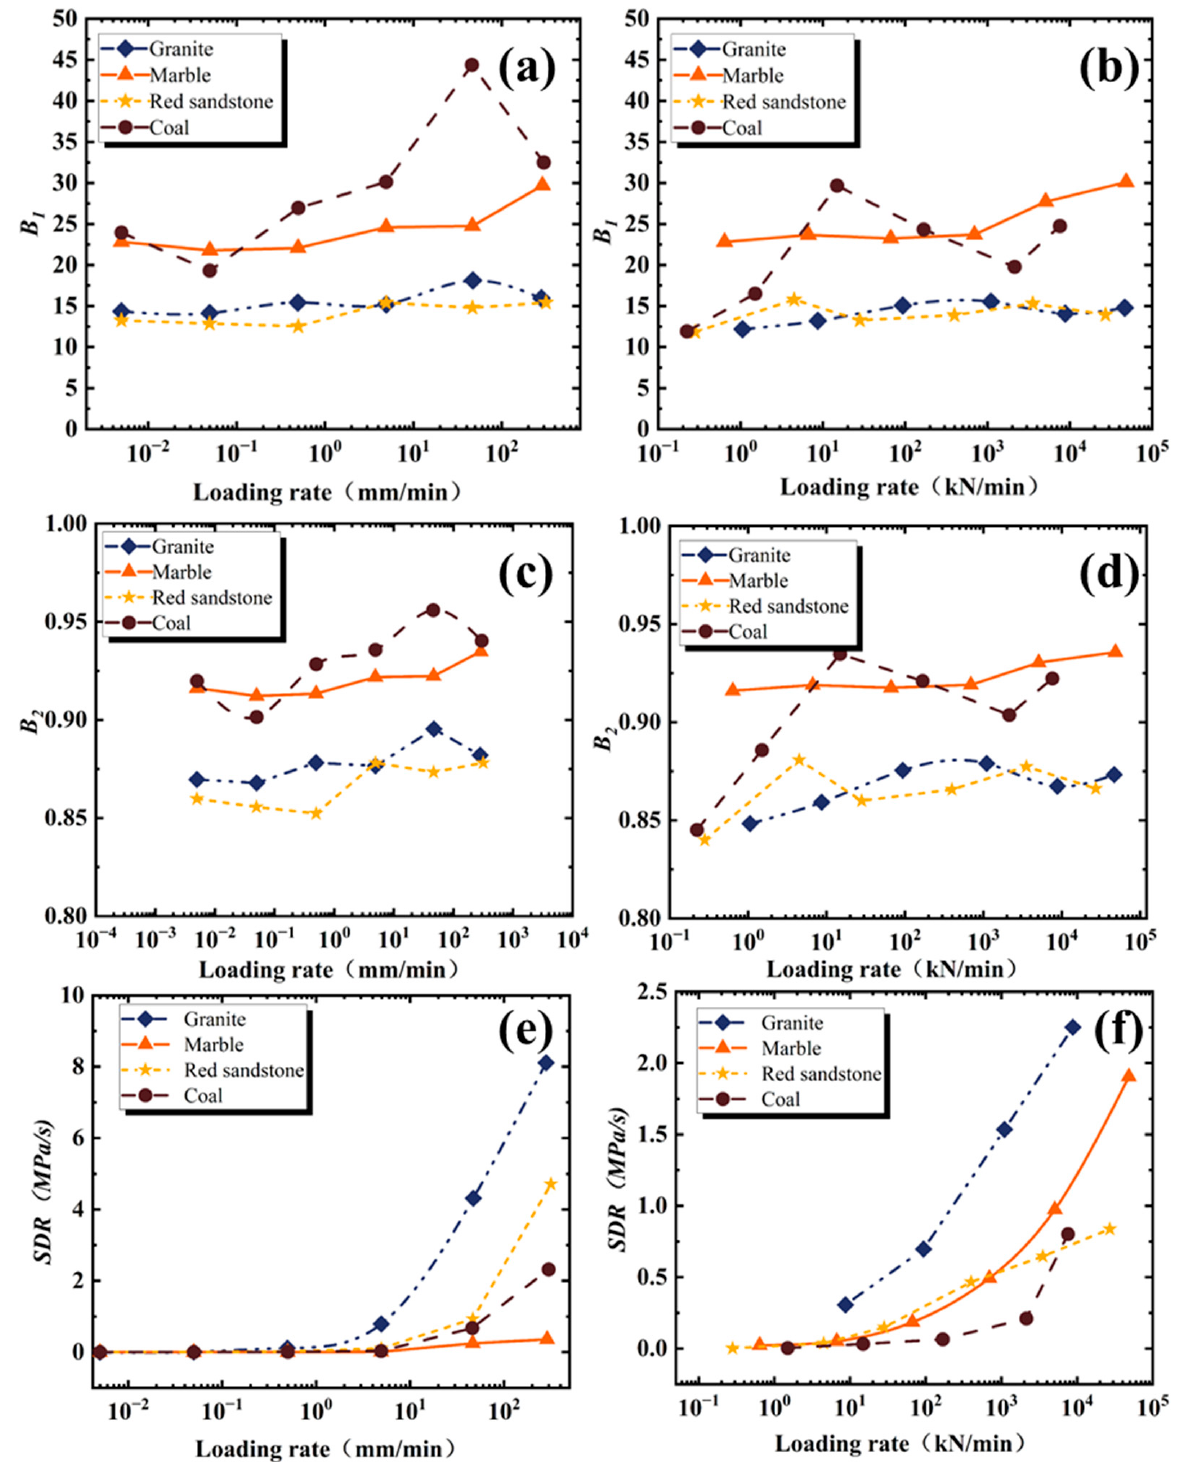
Figure 5. Effect of loading rate on B 1, B 2, and SDR : ( a ) B 1 under displacement control mold, ( b ) B 1 under load control mold, ( c ) B 2 under displacement control mold, ( d ) B 2 under load control mold, ( e ) SDR under displacement control mold, ( f ) SDR under load control mold